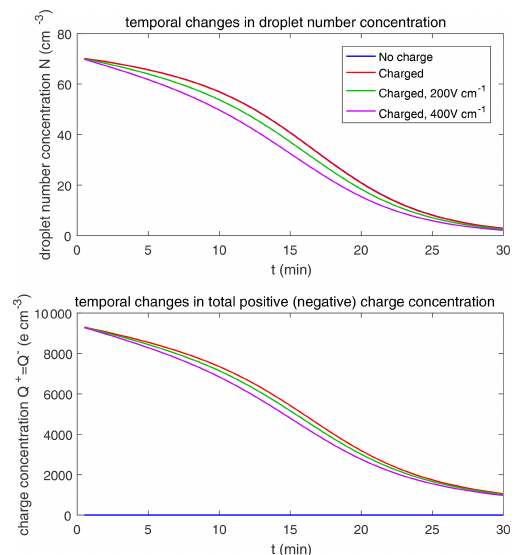
Figure 10. Temporal changes in droplet total number concentration and total charge content for ¯ r =